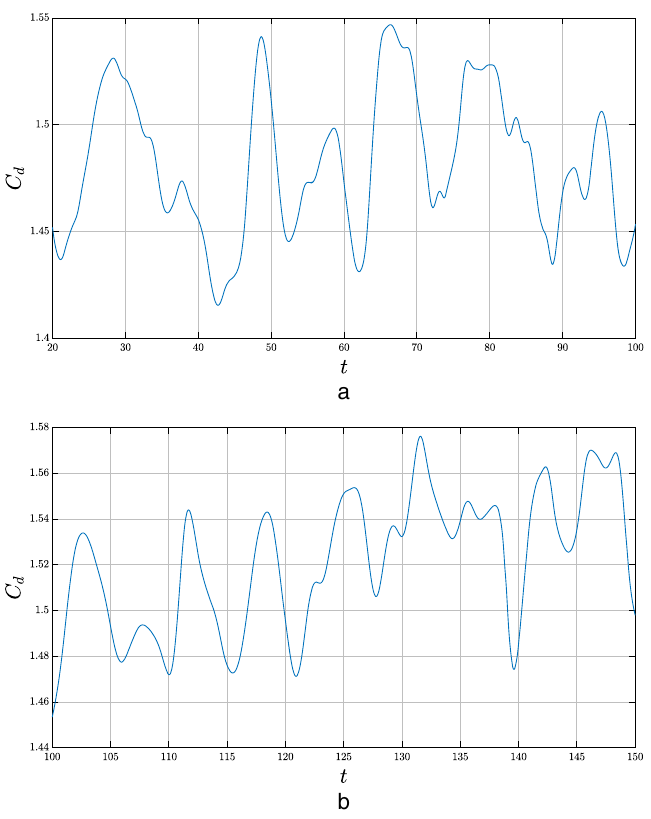
Fig. 11 The drag coefficient of the cubic obstacle for the build-up phase and the offline snapshots time-window. (a) The time-history of the drag coefficient C d during the build-up phase in the time interval [20, 100]. (b) The time-history of the drag coefficient C d in the snapshots time-window [100, 150]